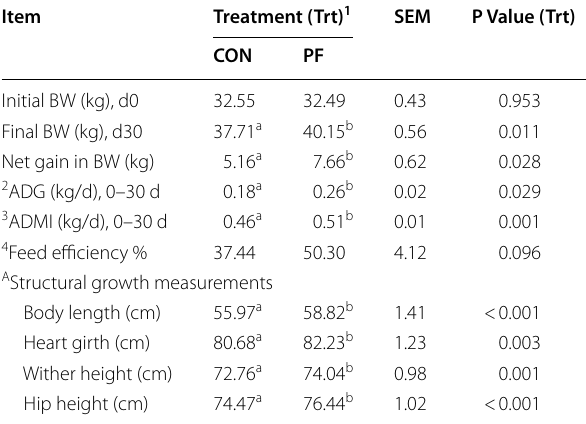
Table 2 Growth performance and structural measurements of Murrah buffalo calves supplemented with probiotic formulation (PF) or not (CON)